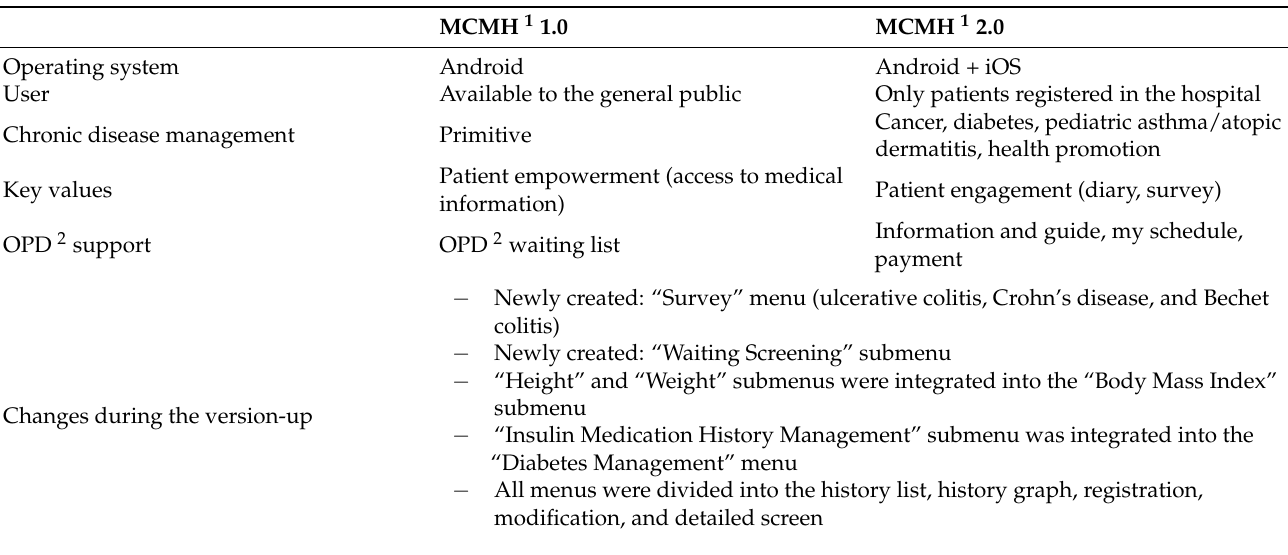
Table 1. Differences in the features between MCMH 1 1.0 and MCMH 1 2.0.